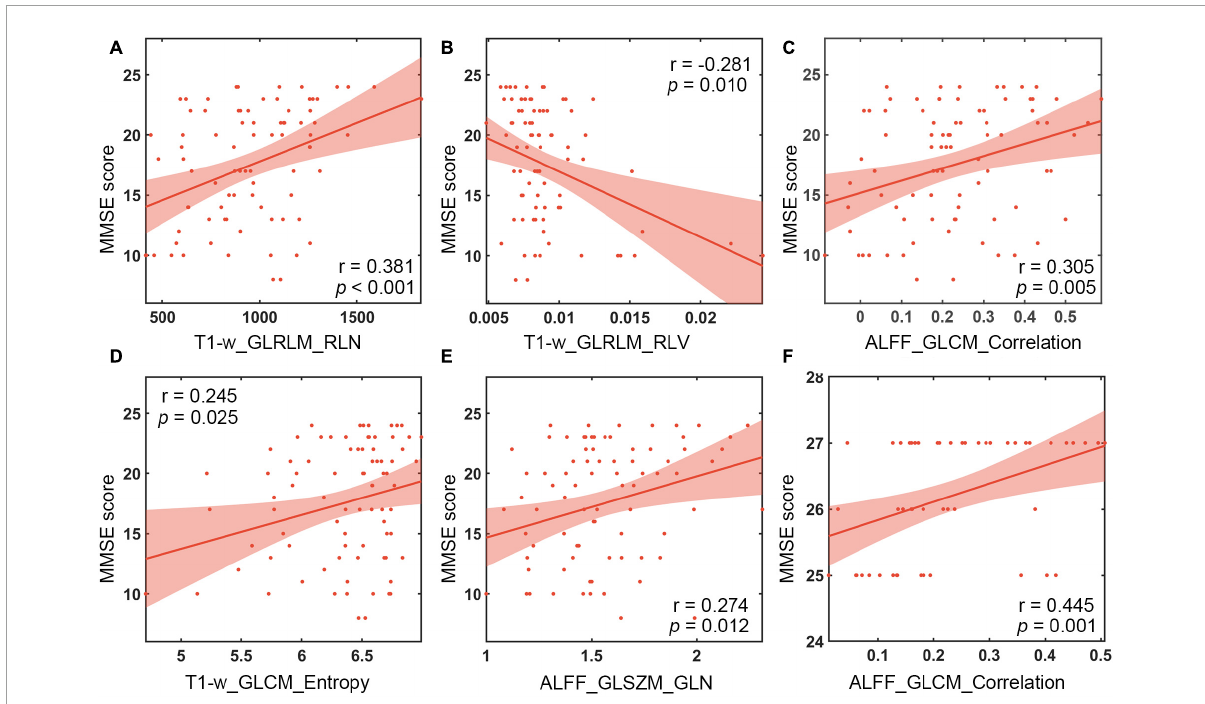
FIGURE3 Correlation analysis between MMSE scales and textural features. (A) Correlation of T1-w_GLRLM_RLN in the left hippocampus with MMSE scores of AD patients. (B) Correlation of T1-w_GLRLM_RLV in the left hippocampus with MMSE scores of AD patients. (C) Correlation of ALFF_GLCM_Correlation in the left hippocampus with MMSE scores of AD patients. (D) Correlation between T1-w_GLCM_Entropy in the right hippocampus and MMSE scores of AD patients. (E) Correlation of ALFF_GLSZM_GLN in the right hippocampus with MMSE scores of AD patients. (F) Correlation of ALFF_GLCM_Correlation in the left hippocampus with MMSE scores of aMCI patients. MMSE, Mini Mental State Test; ALFF, the amplitude of low frequency